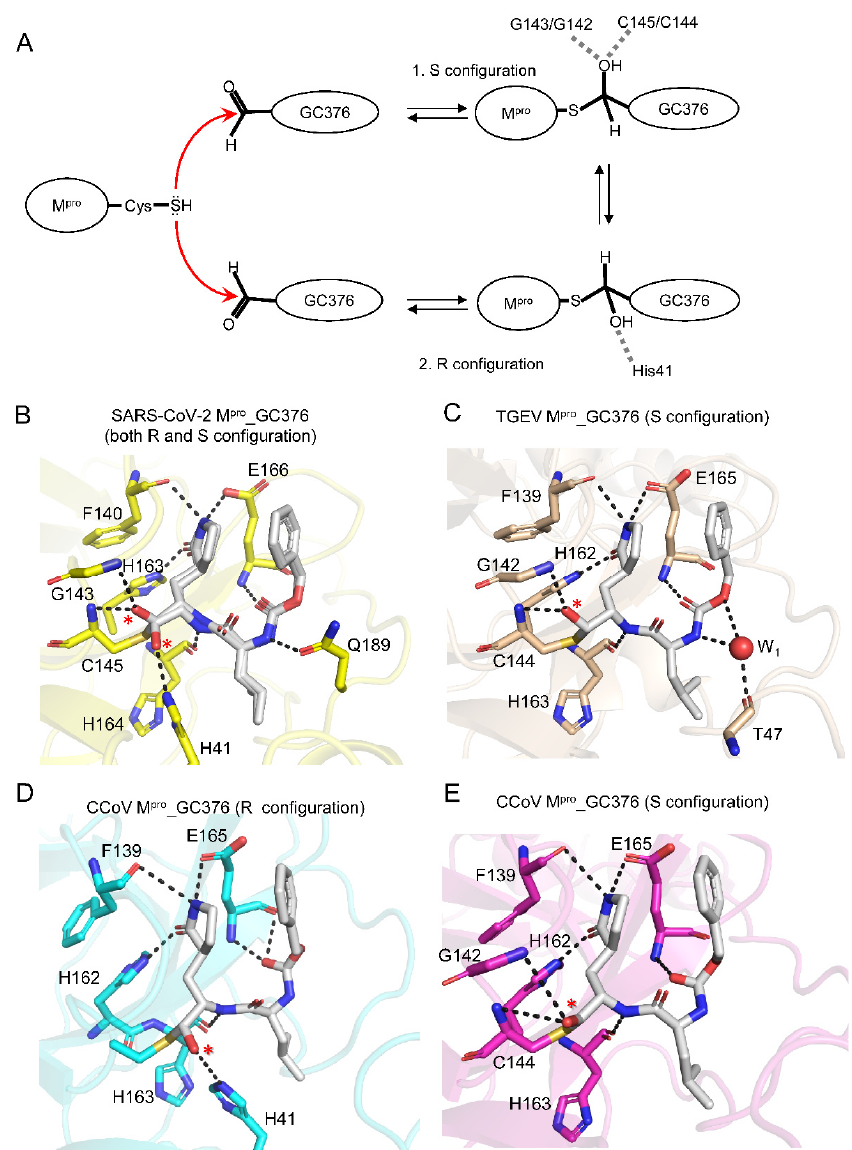
Figure 3. Comparison of the interactions between GC376 and different CoV M pro s: ( A ) Molec- ular mechanism underlying formation of an (R)- or (S)-configuration of GC376 by CoV M pro ; ( B – E ) enlarged views of the substrate-binding pockets from ( B ) SARS-CoV-2 M pro _GC376 (PDB: 7CB7), ( C ) TGEV M pro _GC376 (PDB: 4F49), ( D ) protomer C of CCoV M pro _GC376, and ( E ) protomer A of CCoV M pro _GC376. The hydroxyl groups of the hemithioacetal from covalently linked GC376 are indicated by red star (*). H-bonds are shown as black dashed lines. A water molecule is shown as a red